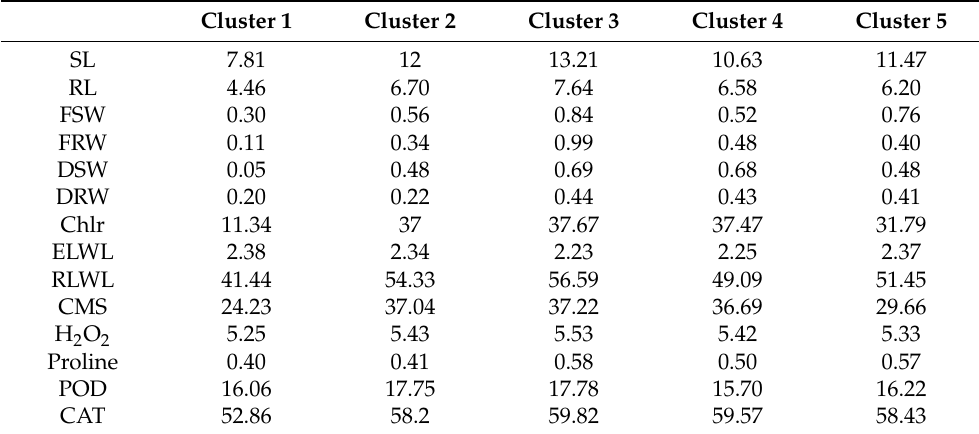
Table 5. K-means cluster analysis of 50 cotton genotypes grown under 75% drought level.